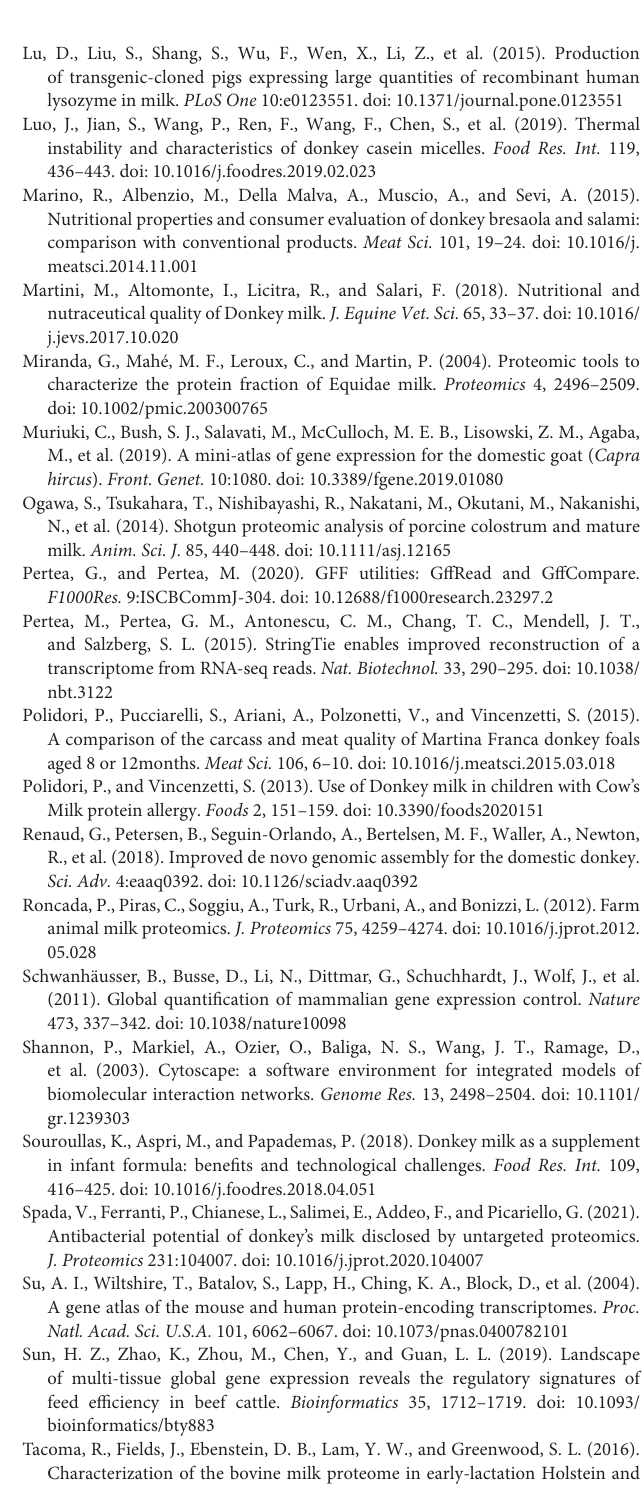
Supplementary Table 7 | Intensity-based absolute quantification values of the 265 identified proteins in donkey milk. Supplementary Table 8 | Annotation of proteins compared with Gene Ontology, Clusters of Orthologous Groups, and Kyoto Encyclopedia of Genes and Genomes